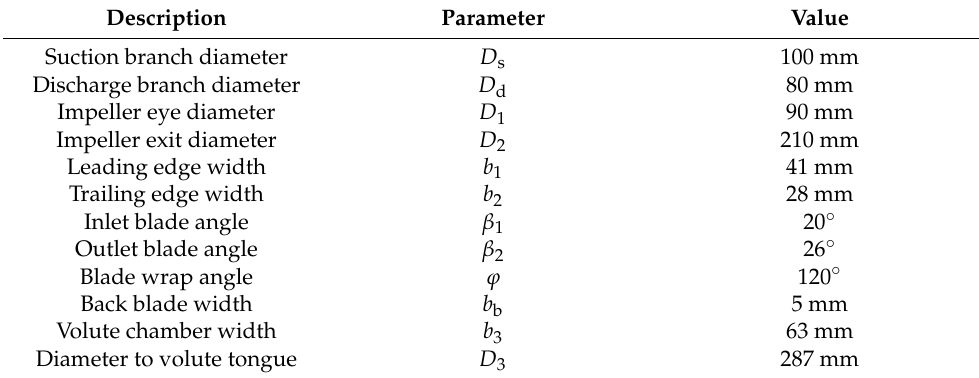
Table 1. Main geometric dimensions.